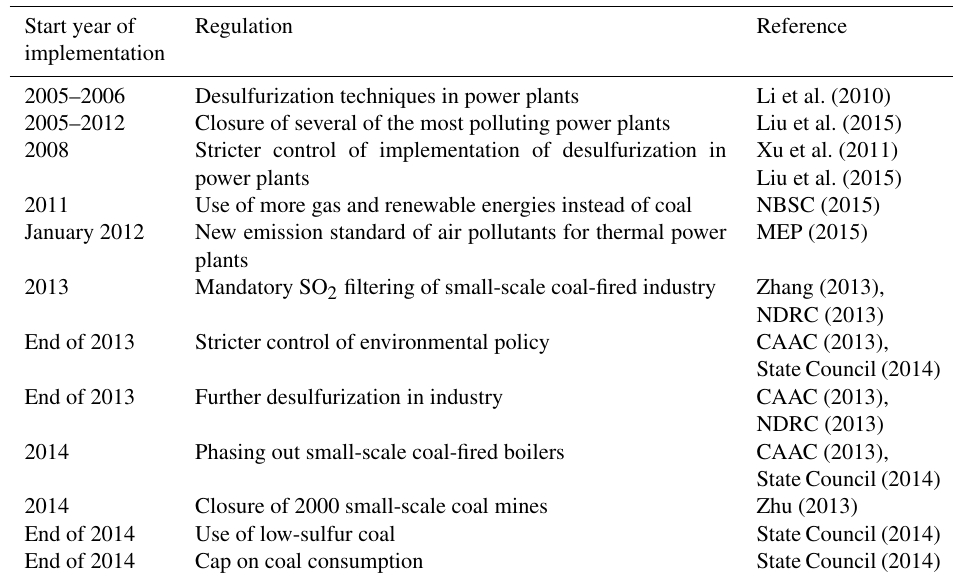
Table 1. Environmental regulations of the Chinese national government to reduce SO 2 in the air.